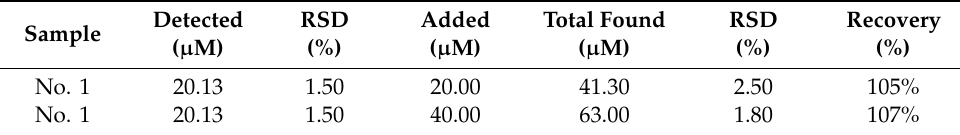
Table 2. Detection of Trp in human serum sample by SDLSV ( n = 3).